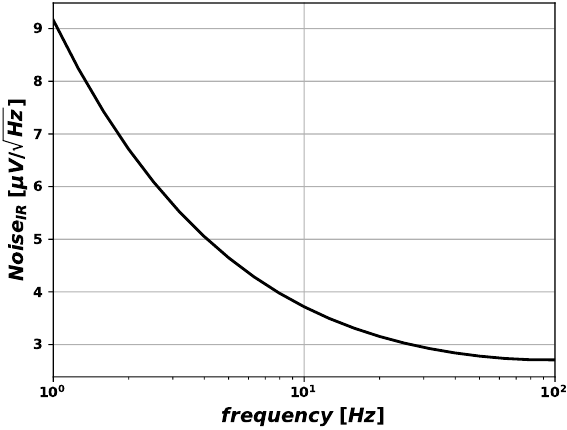
Figure 10. Equivalent input